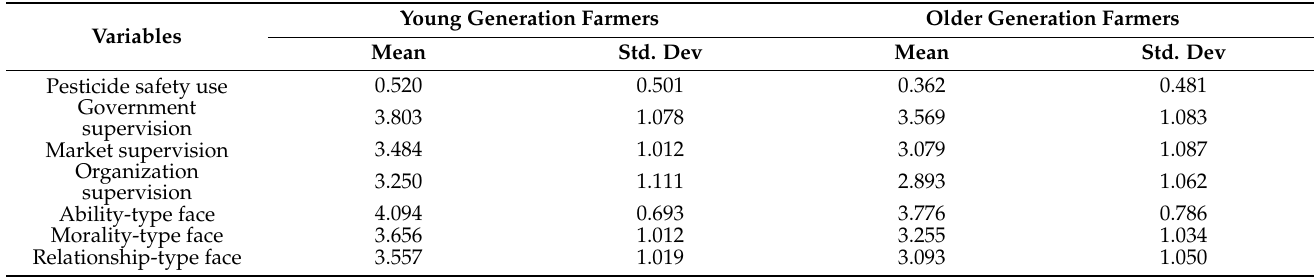
Table 6. Descriptive statistics of selected variables for both old and new generations of